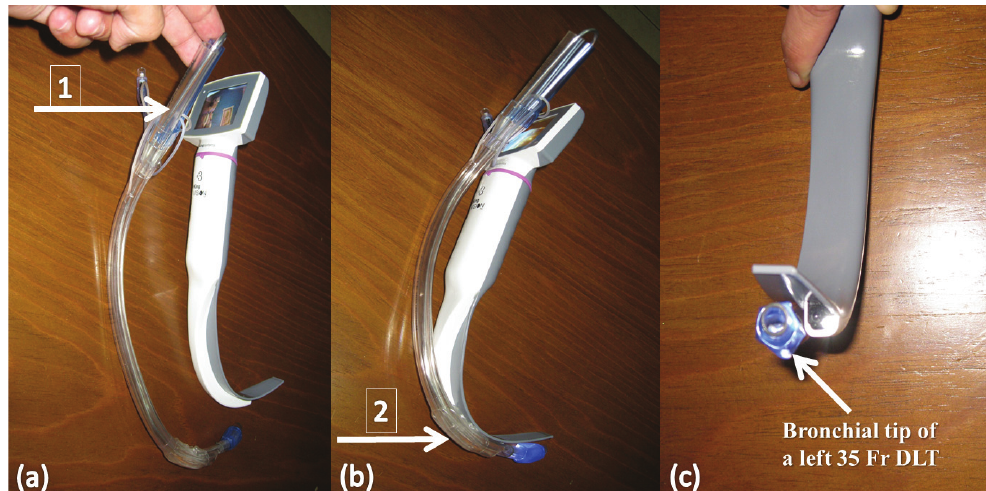
Figure 1. Photograph of a “standard” non-channeled blade of the King Vision™ videolaryngoscope with a stylet placed in a left 35 Fr double-lumen tube (DLT) to match the contour of the blade. ( a ) Arrow (1) shows how the proximal DLT curve remains directed to the right side. ( b ) Arrow (2) shows how the distal DLT curve follows the curve of the standard non-channeled blade (approximately 60–70°). ( c ) Shows the bronchial tip of the DLT adapted to the tip of the standard non-channeled blade.